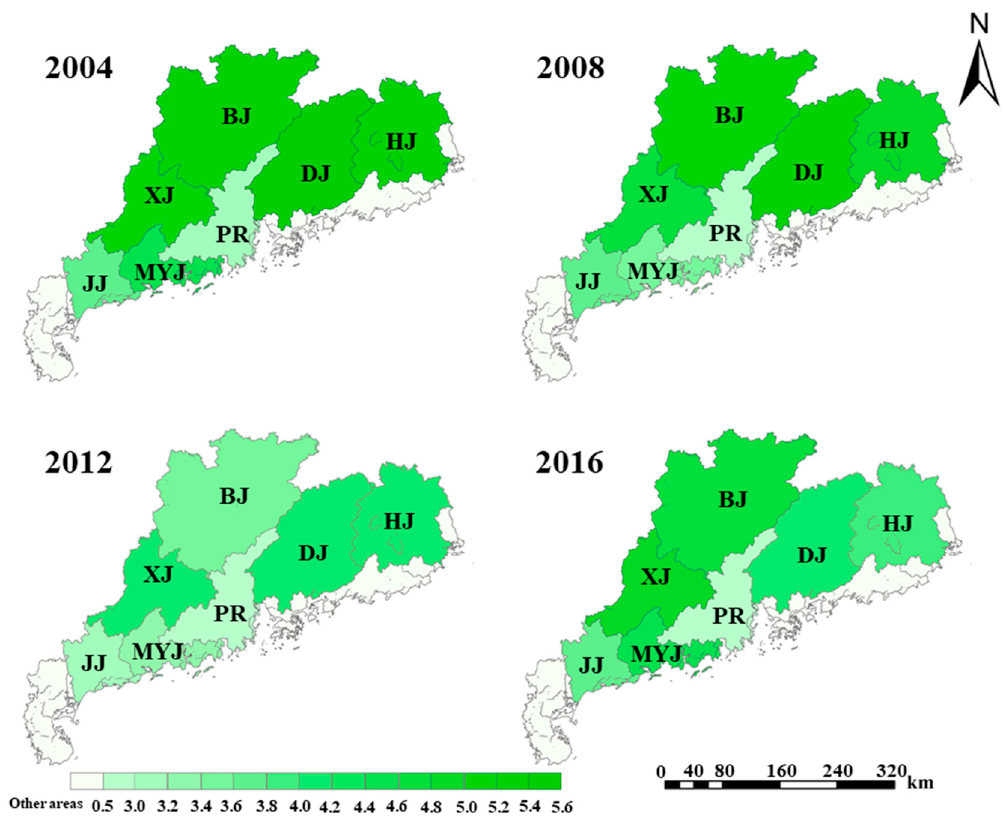
Figure 10. Spatial patterns of the annual mean CRIR in seven major river basins in Guangdong.